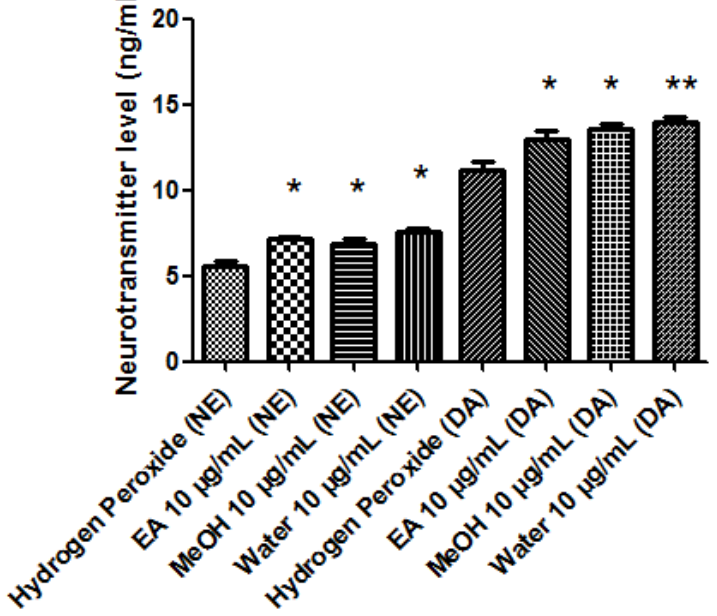
Figure 4. E ff ects of P. africanum water, methanol (MeOH), and ethylacetate (EA) extracts (10 µ g / mL) on extracellular levels (ng / mL) of dopamine (DA) and norepinephrine (NE). Neurotransmitters were measured in the medium of hypothalamic HypoE22 cells stimulated with extracts and challenged with hydrogen peroxide (1 mM). ANOVA, p < 0.01; post hoc test, * p < 0.05, ** p < 0.01 vs. Hydrogen Peroxide